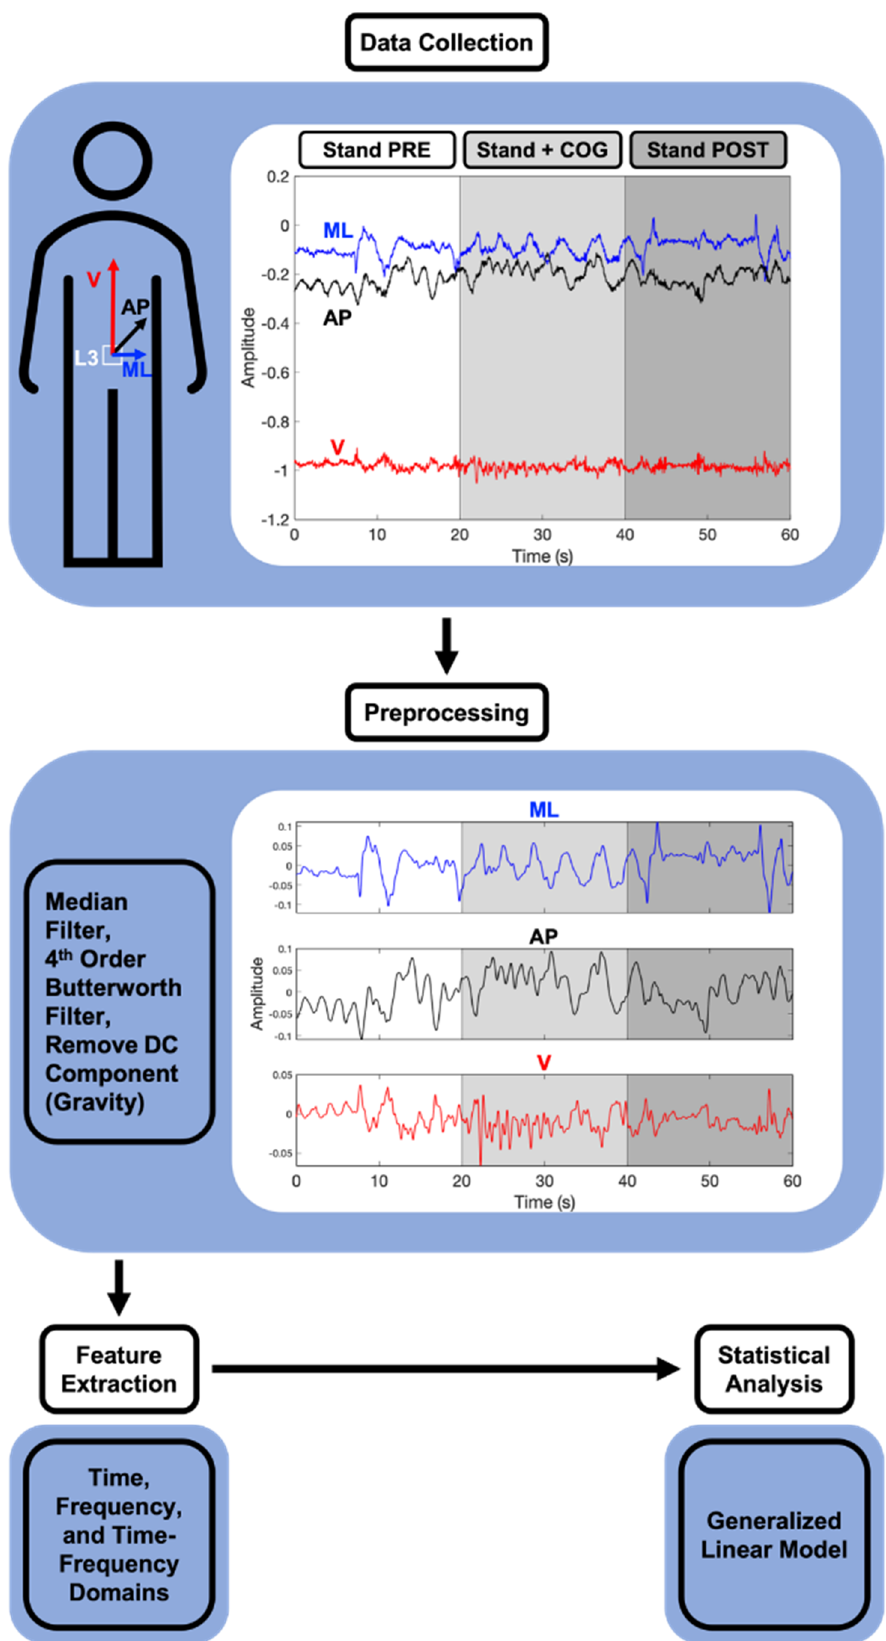
Figure 1. Flow diagram of the data processing pipeline to extract accelerometry features.